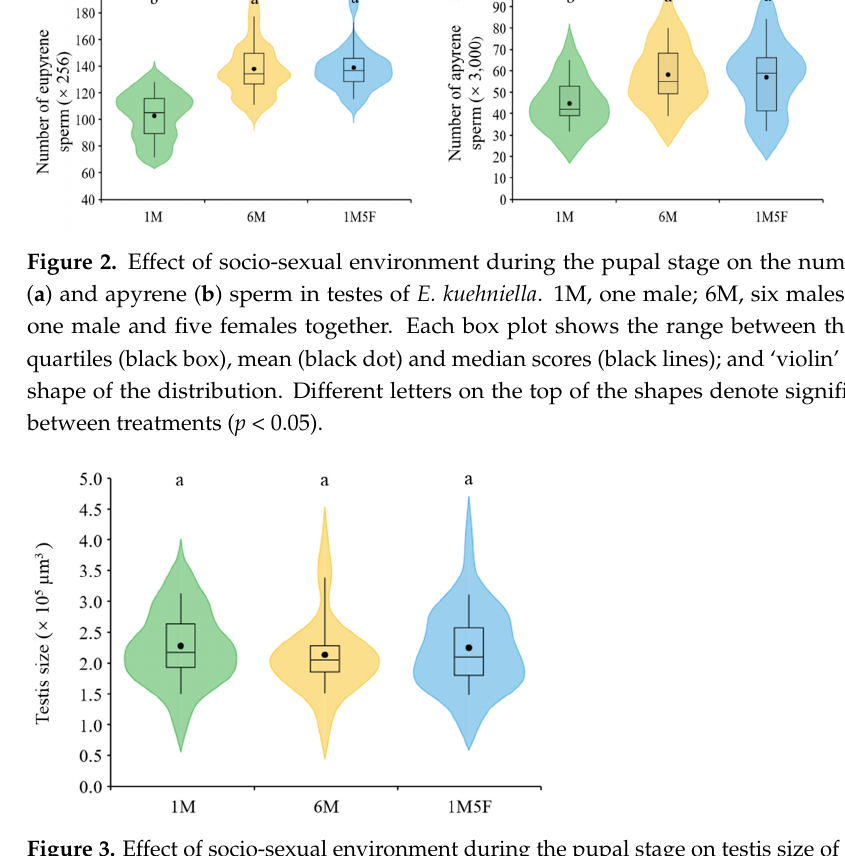
Figure 4. Relationship between the number of eupyrene and apyrene sperm produced. For 1M (one male), ln(eupyrene) = 6.58 + 0.31 × ln(apyrene), R 2 = 0.1594; for 6M (six males together), ln(eupyrene) = 6.59 + 0.32 × ln(apyrene), R 2 = 0.2990; and for 1M5F (one male and five females together), ln(eupy- rene) = 7.54 + 0.24 × ln(apyrene), R 2 = 0.3729. 4. Discussion We demonstrate for the first time that male pupae of an insect increased sperm pro- duction after exposure to conspecific pupal cues regardless of sex (Figure 2). Previous studies report that male insect larvae also can increase their investment in sperm in the presence of non-sex specific larval cues [17,19–21]. These findings indicate that juvenile male insects can predict future sperm competition risks from cues of conspecific immature stages and subsequently adjust their sperm production [17,19,69–71]. In lepidopteran in- sects, adults [10] and pupae (current study) adjust production of both fertile eupyrene and infertile apyrene sperm, while larvae only fine-tune production of eupyrene sperm [19] in response to socio-sexual environments. Furthermore, larvae either increase [17,40] or re- duce [19] testis size in response to larval cues but pupae (Figure 3) and adults do not change their testis size under different socio-sexual situations. These discoveries suggest that resource allocation to sperm production and testis size differs depending on the life stages exposed to sperm competition environment.